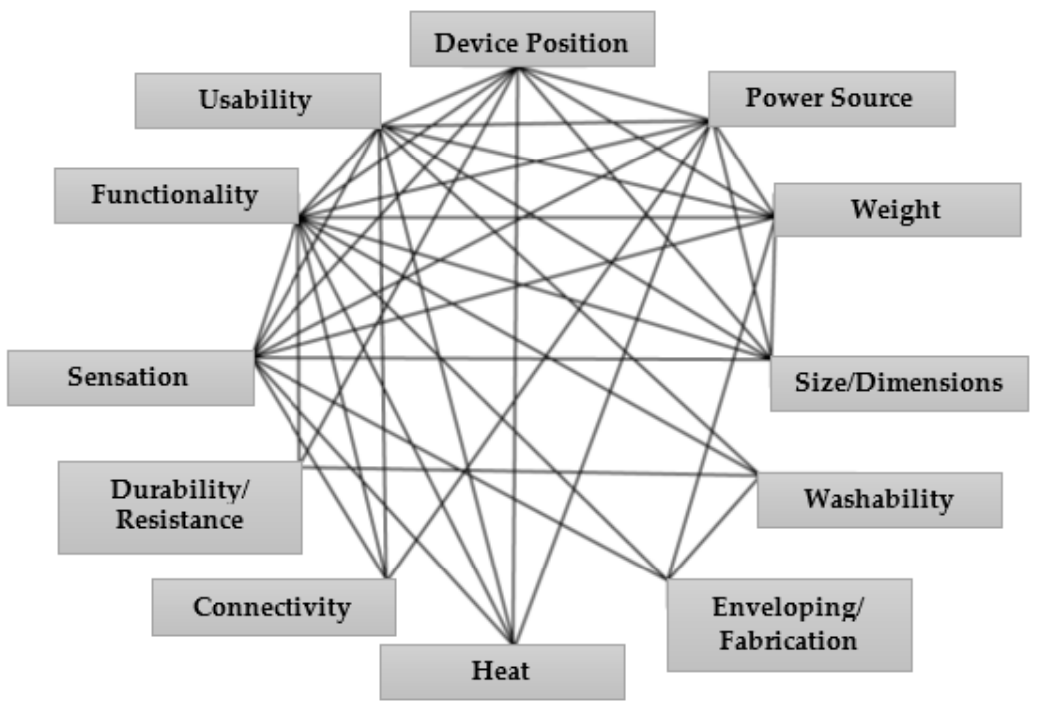
Figure 3. An interconnected architecture of wearable devices.